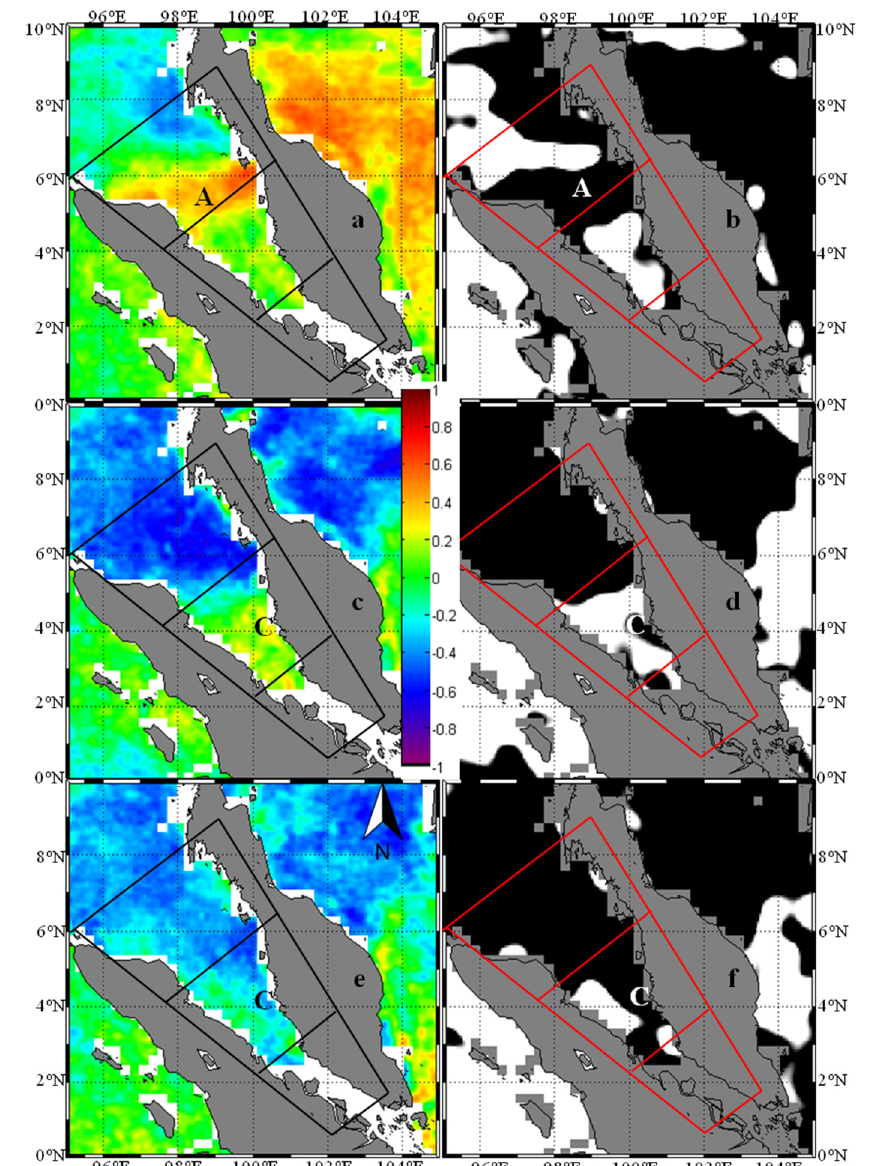
Figure 6. Spatial variations of the correlation coefficient ( r ) and corresponding p -value derived from linear regressions of SeaWiFS chlorophyll- a concentration (Chl- a ) on QuikScat ( a , b ) wind speed (WS); ( c , d ) zonal wind; and ( e , f ) meridional wind. Black